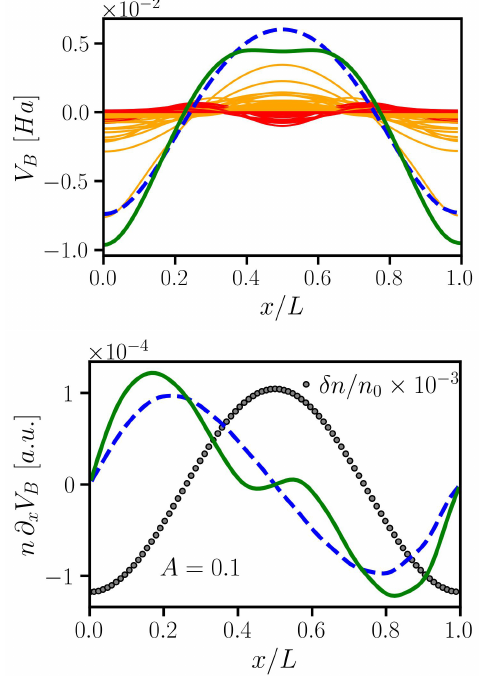
Figure 7: Comparison of the quantum Bohm potentials (top panel) and their induced = 2 and θ = 0.01). The deviations between forces (bottom panel) at q = 0.5 q ( r F s the standard Bohm potential (dashed blue) and the many-fermion quantum Bohm potential (green) persist. The total electron density (grey circles) and the individual contribution of orbitals with one maximum in the center (orange) and with more that one maximum (red) are also illustrated. Note scaling.